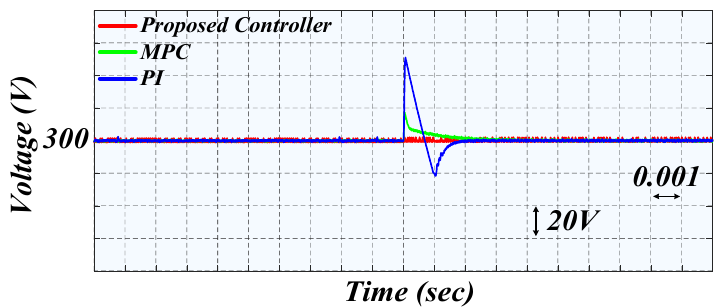
Figure 10. Comparison of the voltage transient responses of the proposed MF-NIBC controller, MPC, and the conventional PI controller during a step change in the output power in the second scenario. Case3: In the last scenario, it is assumed that the nominal voltage of the second EV is 500 V, whereas the voltage of the EV which acts as a source is 400. As mentioned previously, since the EPBC works in emergency mode, it is allowed to transfer up to 15% of the capacity of the battery. Therefore, as depicted in Figure 8a, the injected current is limited between upper and lower predefined values. Figure 11 expresses the transient outcomes of the proposed MF-NIBC controller, MPC controller, and PI controller. With the help of the suggested MF-NIBC controller, Figure 11 indicates that our suggested smart charger has a reliable performance with the lowest overshoot compared to the traditional